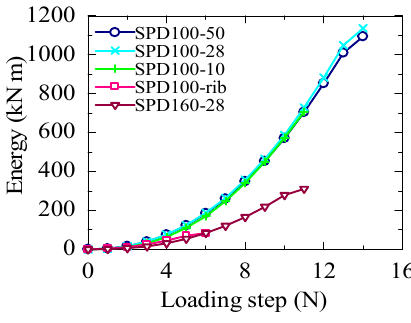
Figure 8. Cumulative energy.